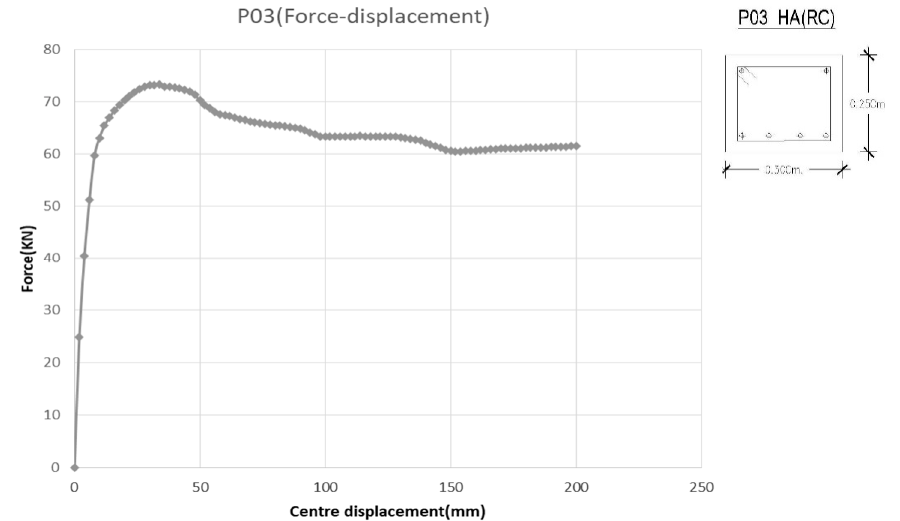
Figure 16. Force–displacement diagram of beam P03 from the numerical model.